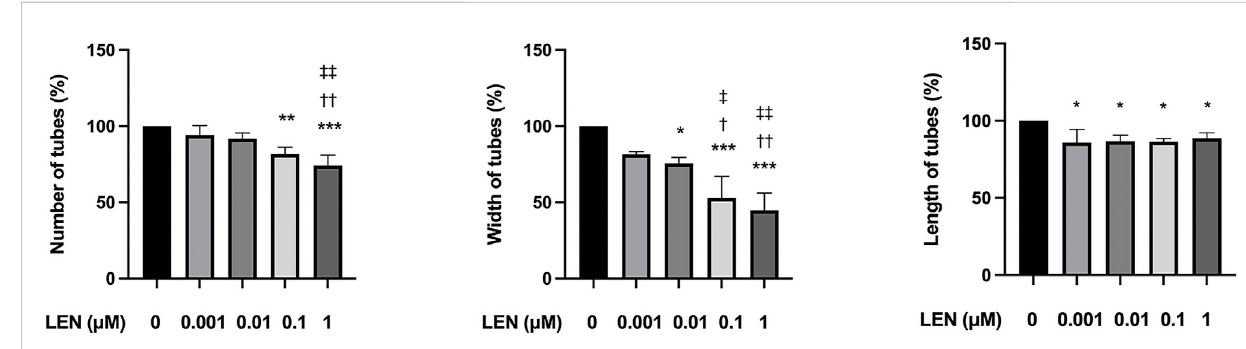
FIGURE 8 Effect of lenvatinib on tube formation in HUVECs. The cells were treated with different concentrations of lenvatinib for 16 h. Data are presented as themean+SD( n =3fromthreeindependentexperiments).* p < 0.05, ** p < 0.01,*** p < 0.001 vs .Ctrlgroup; † p < 0.05, †† p < 0.01vs.0.001 µMLENgroup;